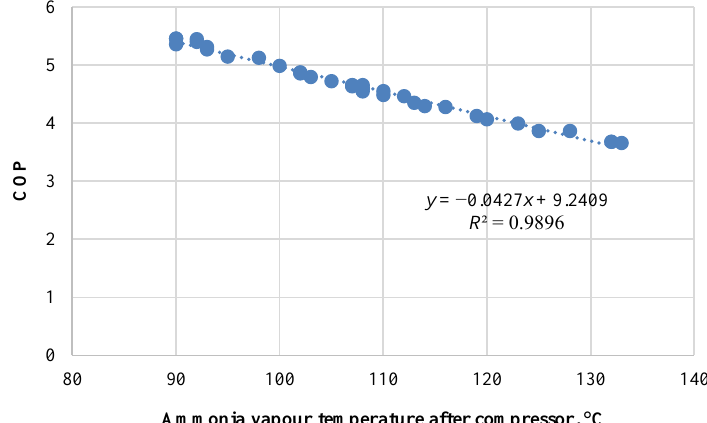
Fig. 9. Single-stage compressor COP depending on ammonia vapour temperature after compressor.